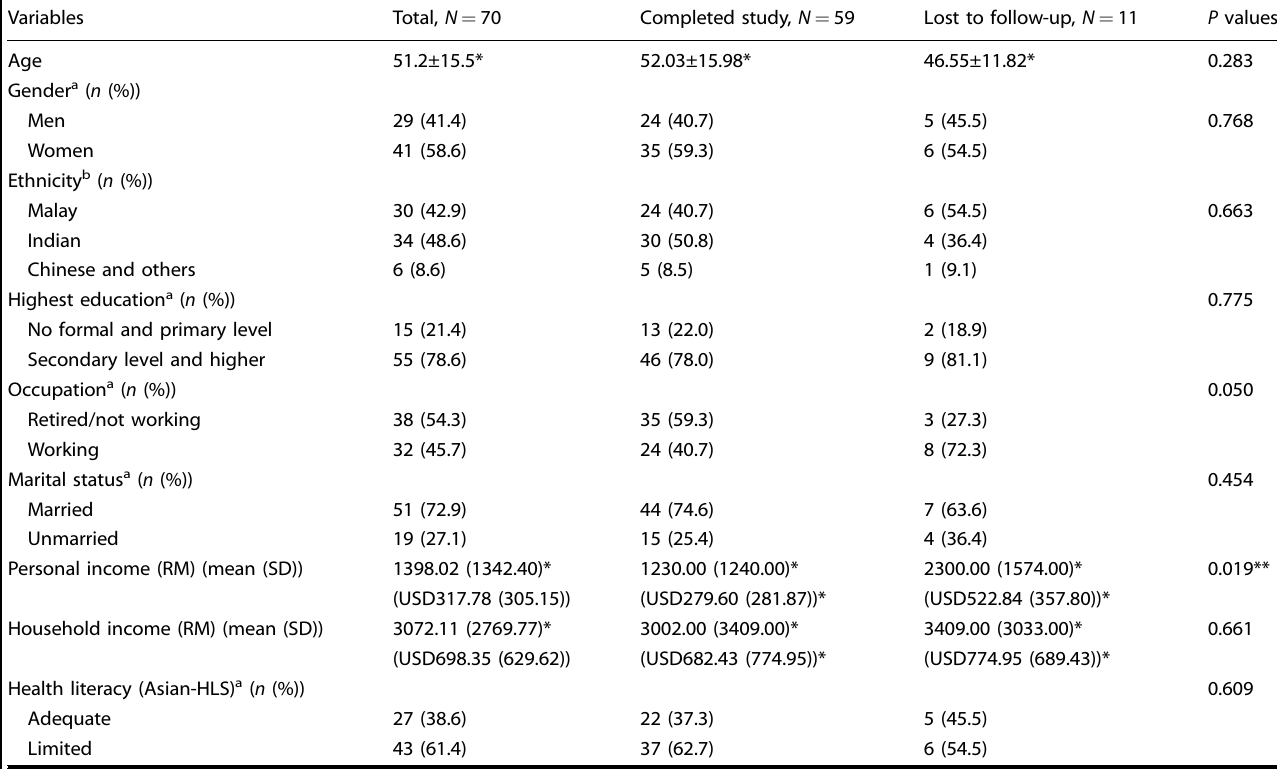
Table 3. Comparisons between participants who completed the study and those lost to follow-up.